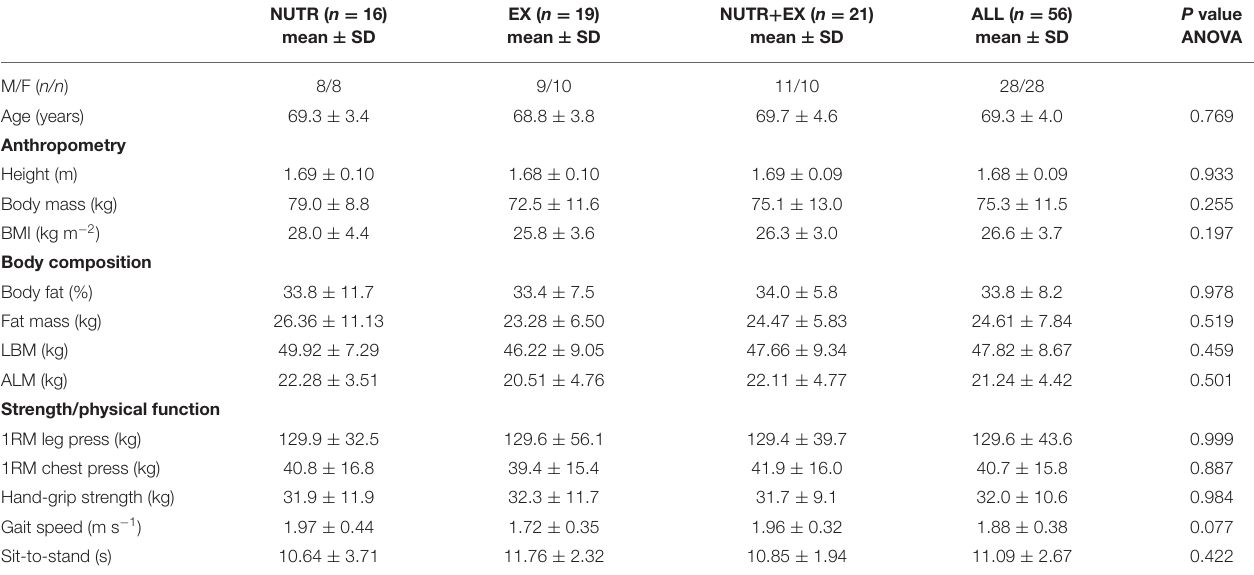
TABLE 1 | Participant characteristics at baseline